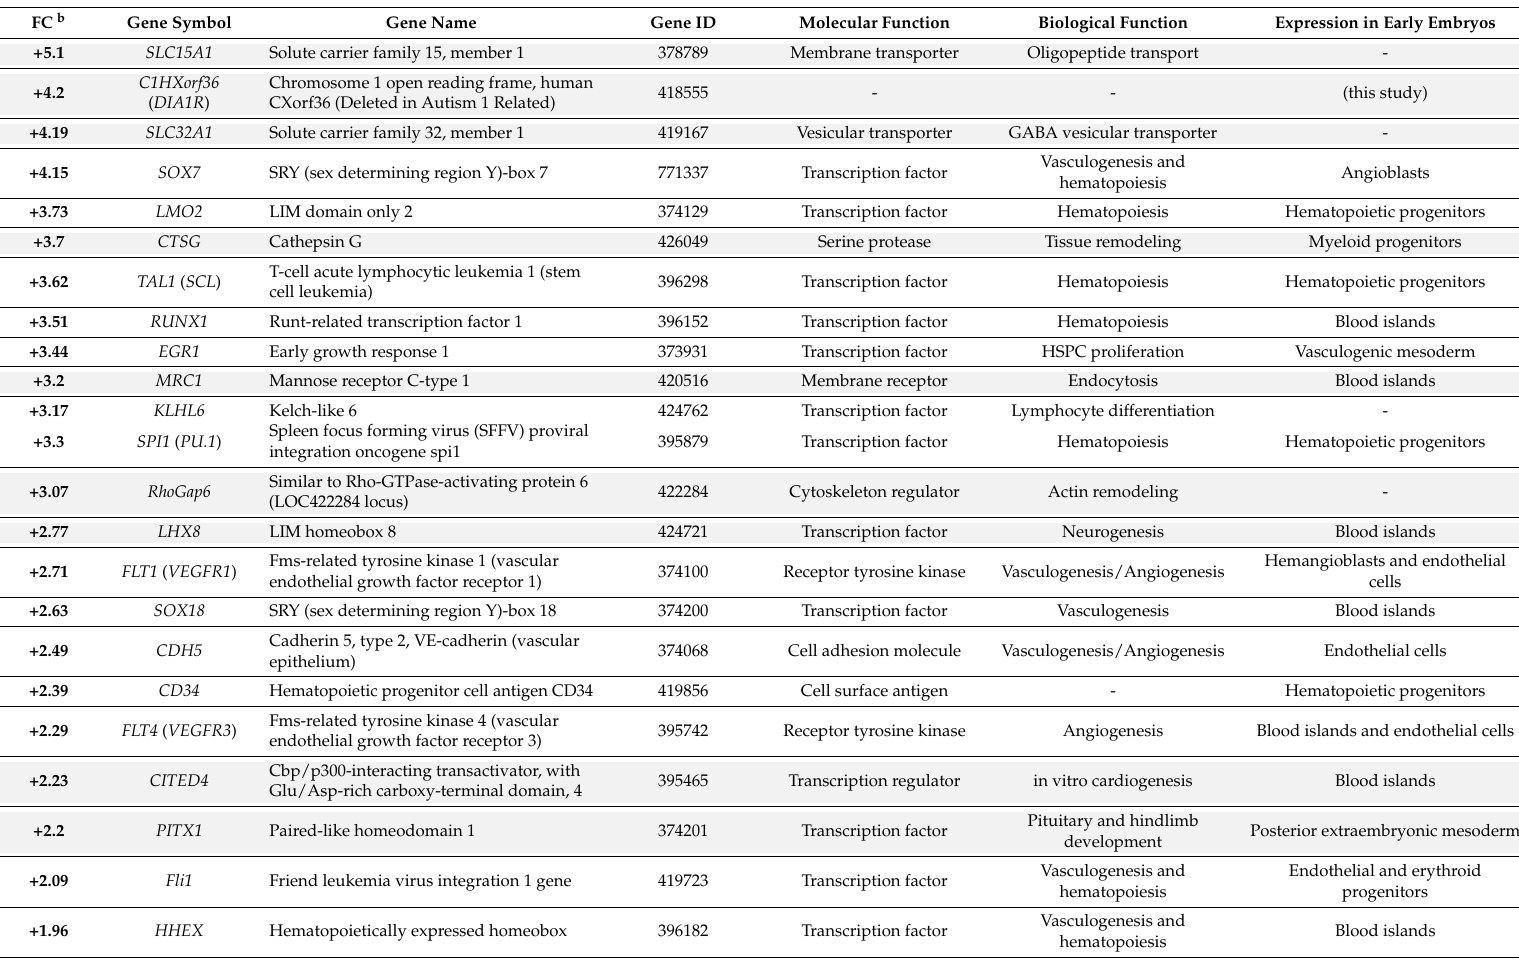
Table 1. List of selected genes upregulated in yolk sac hemangioblasts. Genes without a known function in hematopoiesis or vasculogenesis are highlighted in gray a